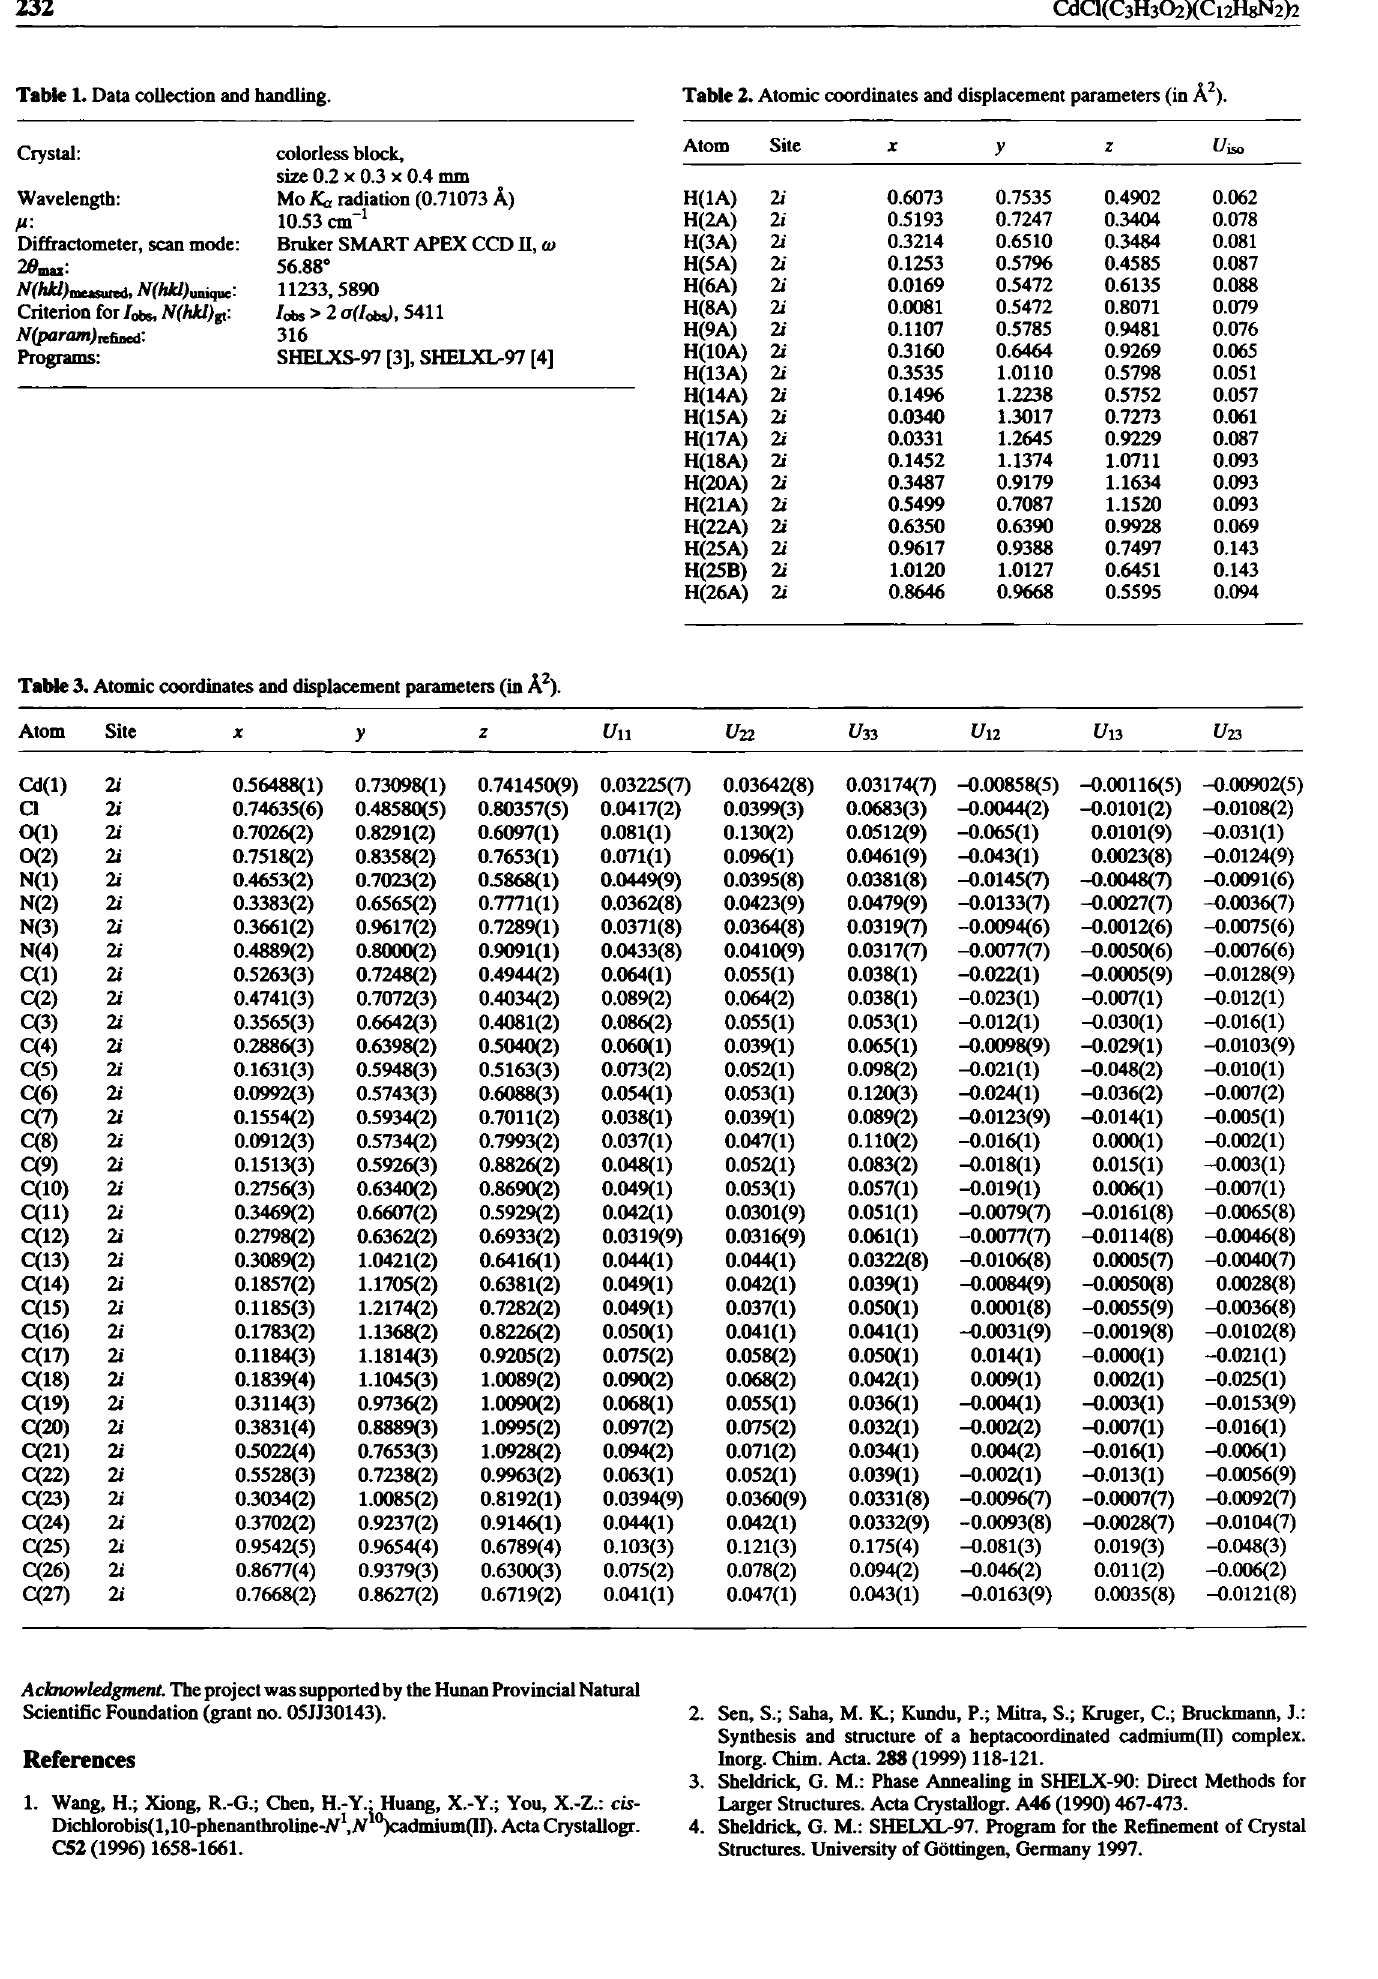
Table 3. Atomic coordinates and displacement parameters (in Ä 2